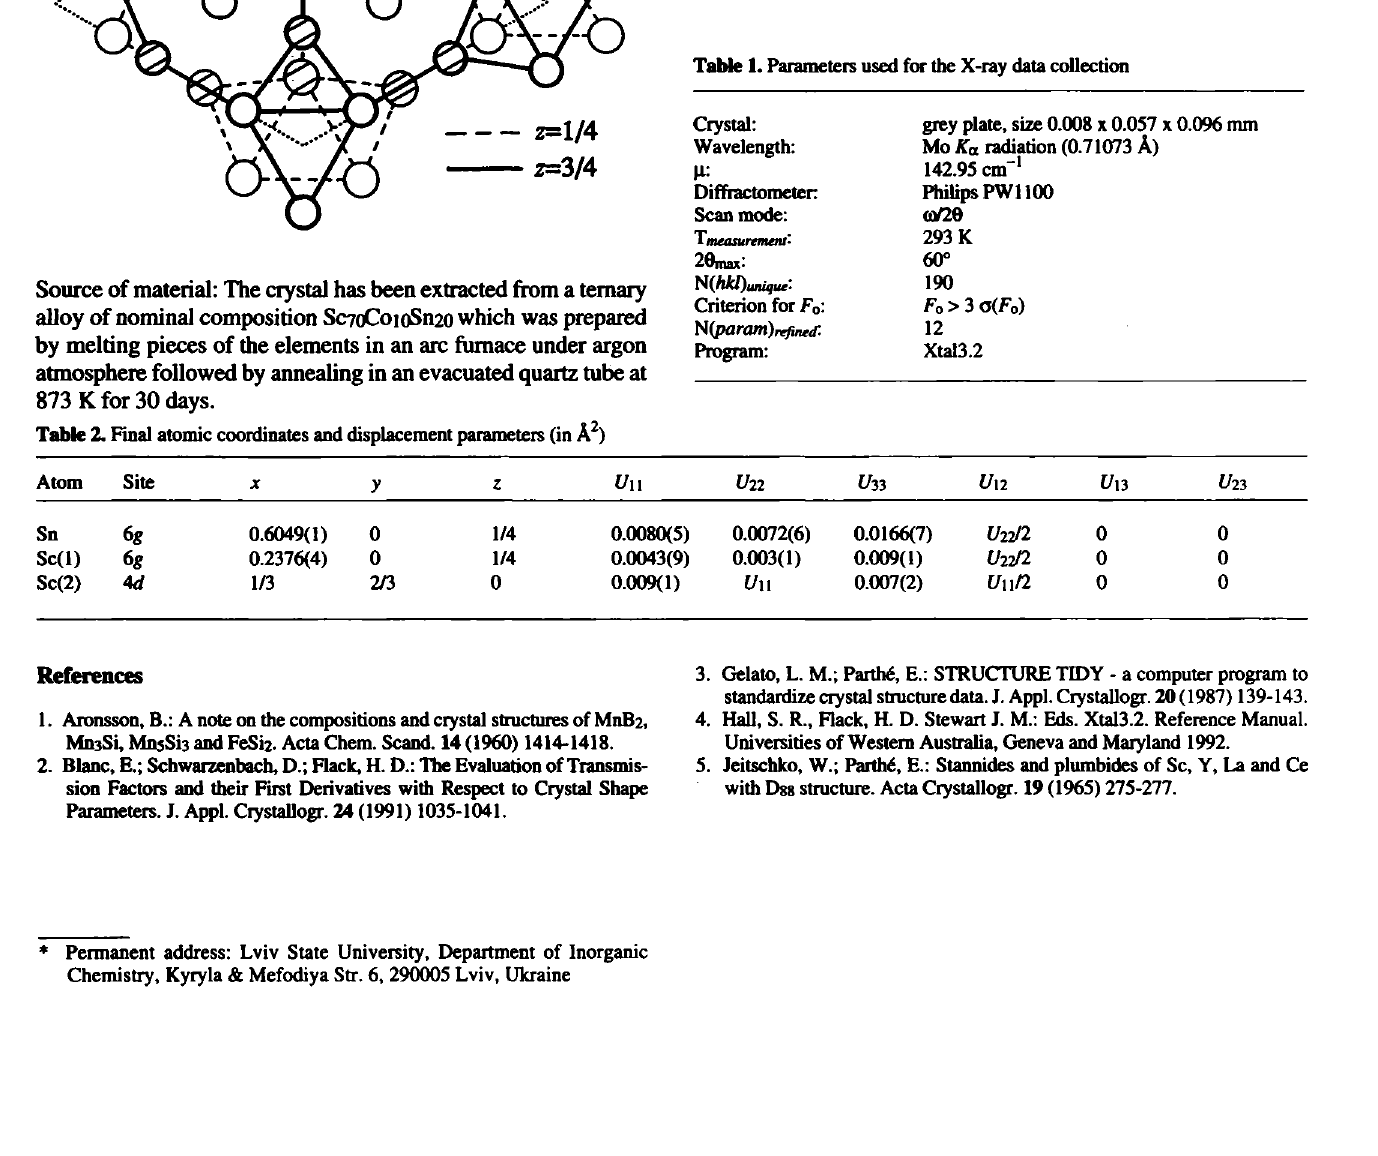
Table 1. Parameters used for the X-ray data collection